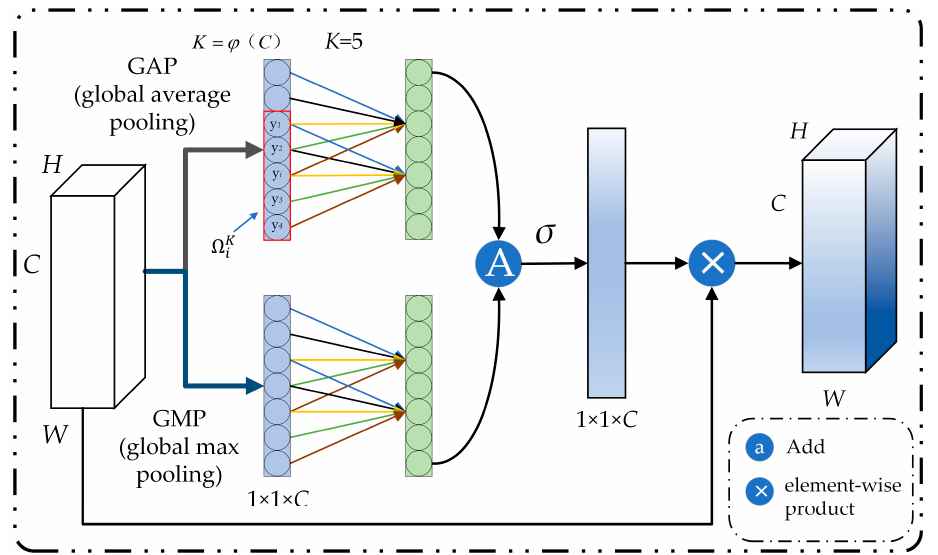
Figure 3. Double efficient channel attention (DECA) module diagram. GAP stands for global average-pooling and GMP stands for global